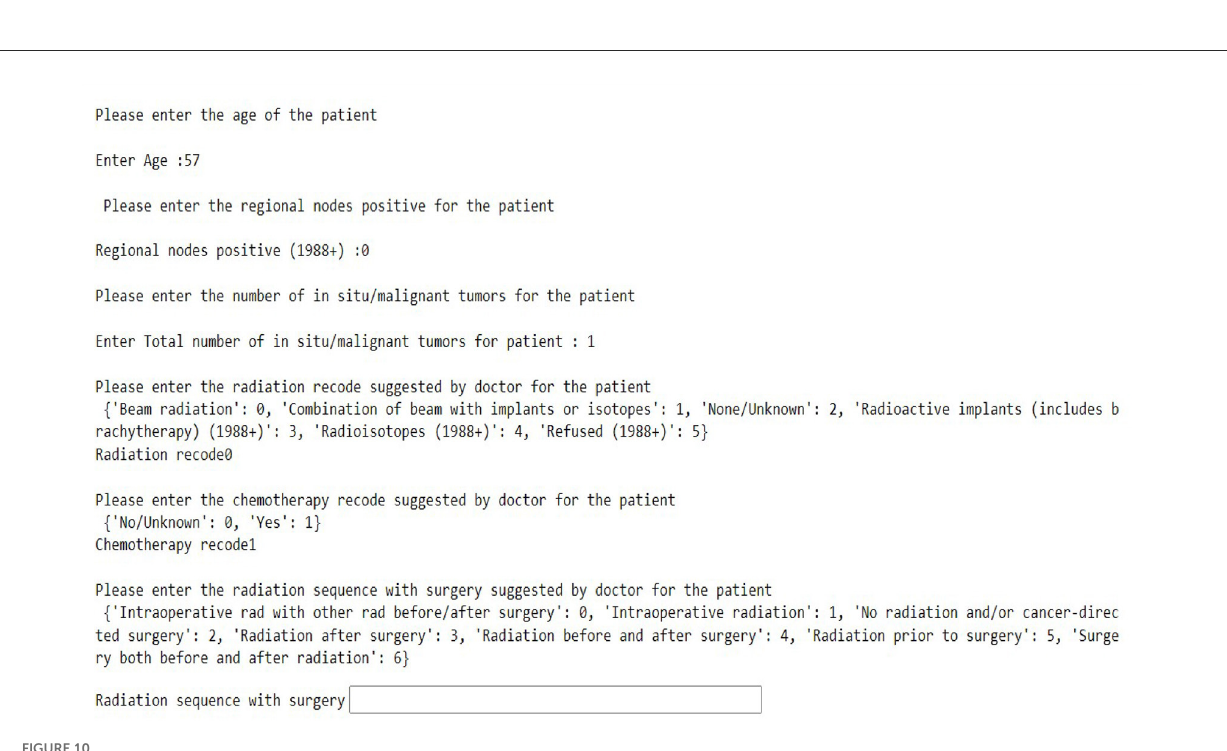
FIGURE10 Interactive